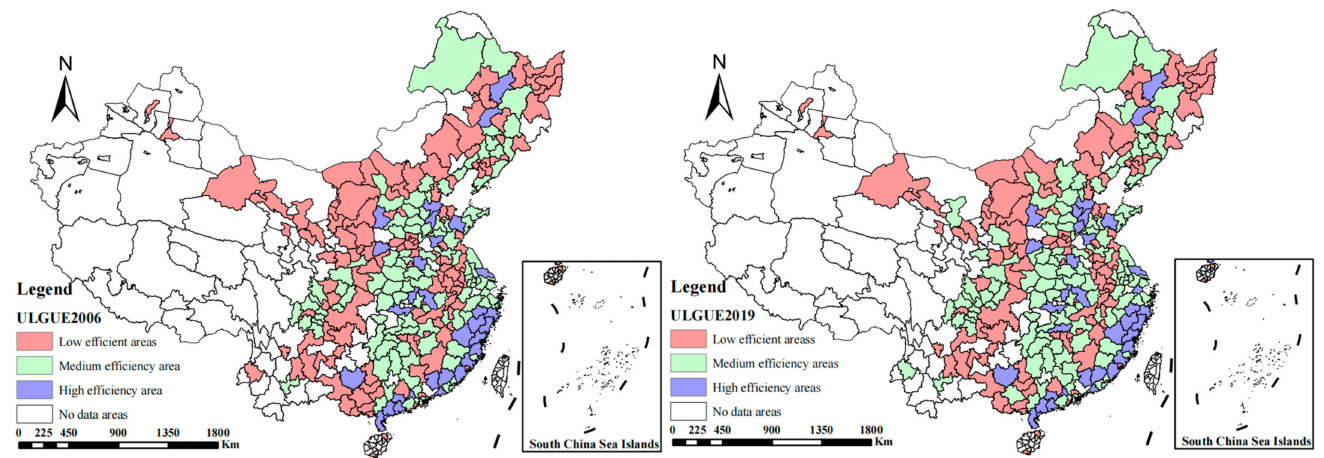
Figure 3. ULGUE distribution changes in 266 prefecture-level cities in 2006 and 2019 in